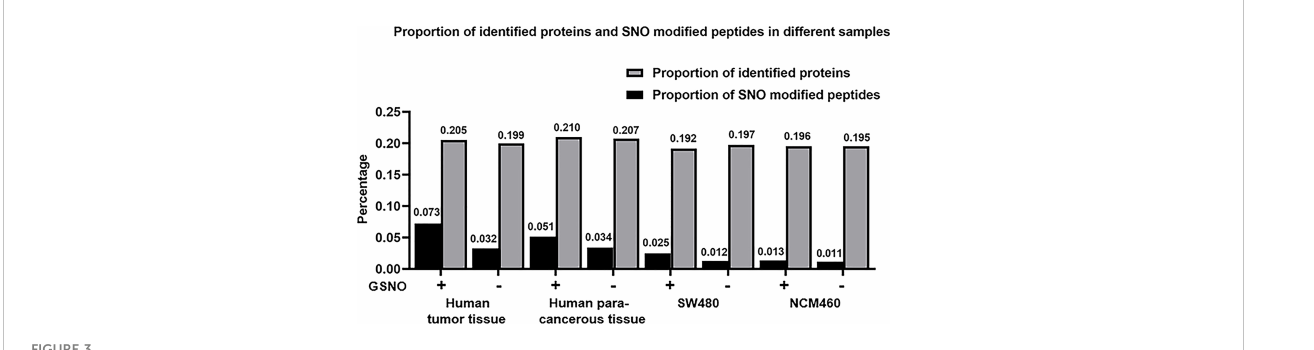
FIGURE 3 The proportion of SNO peptides and identi fi ed proteins in different protein